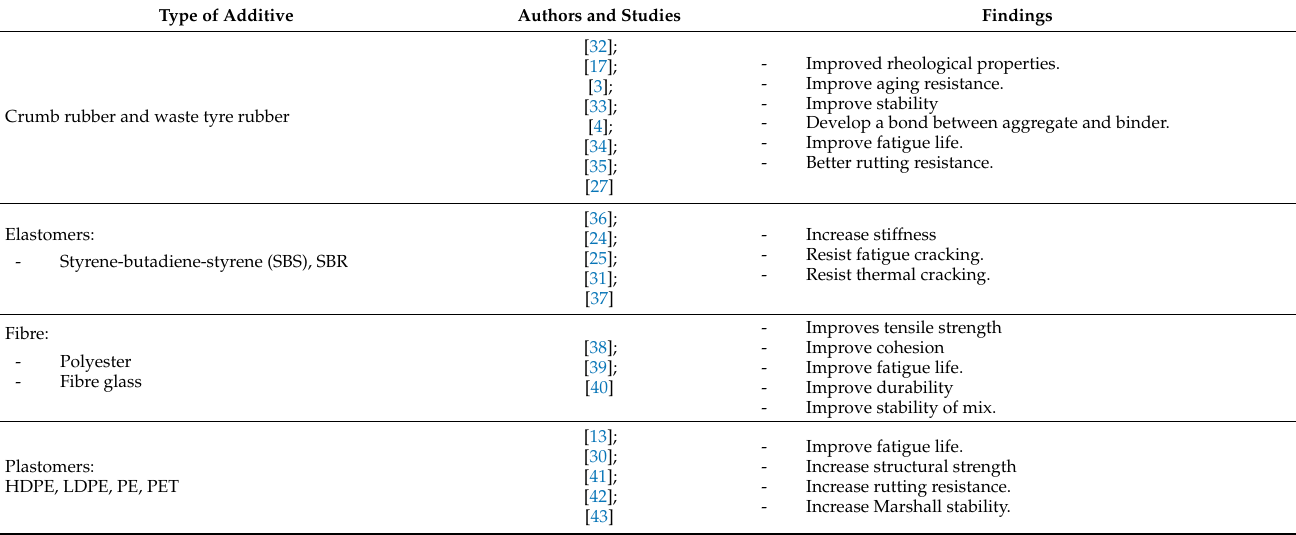
Table 1. Illustration of the various types of polymers and additives used in asphalt